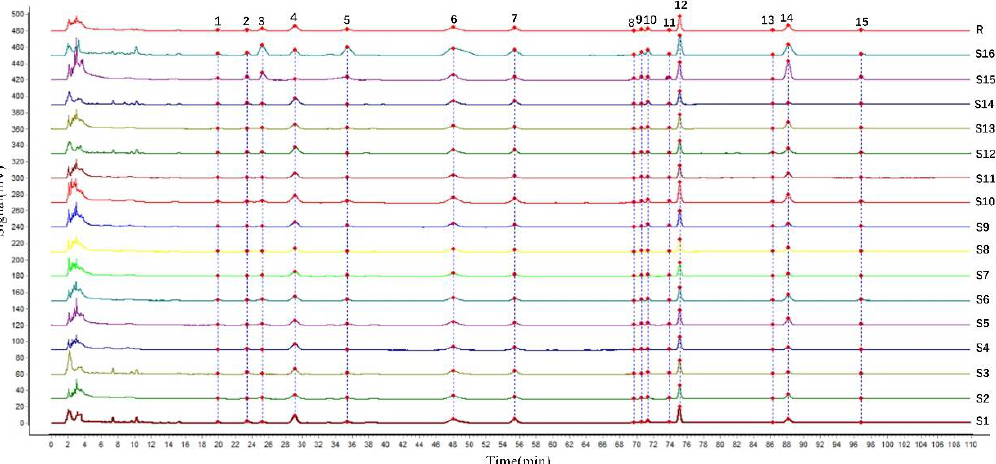
Figure 1. HPLC fingerprints for 16 batches of PC. (R, control chromatogram; S1–S16, 16 batches of PC fingerprints by HPLC).